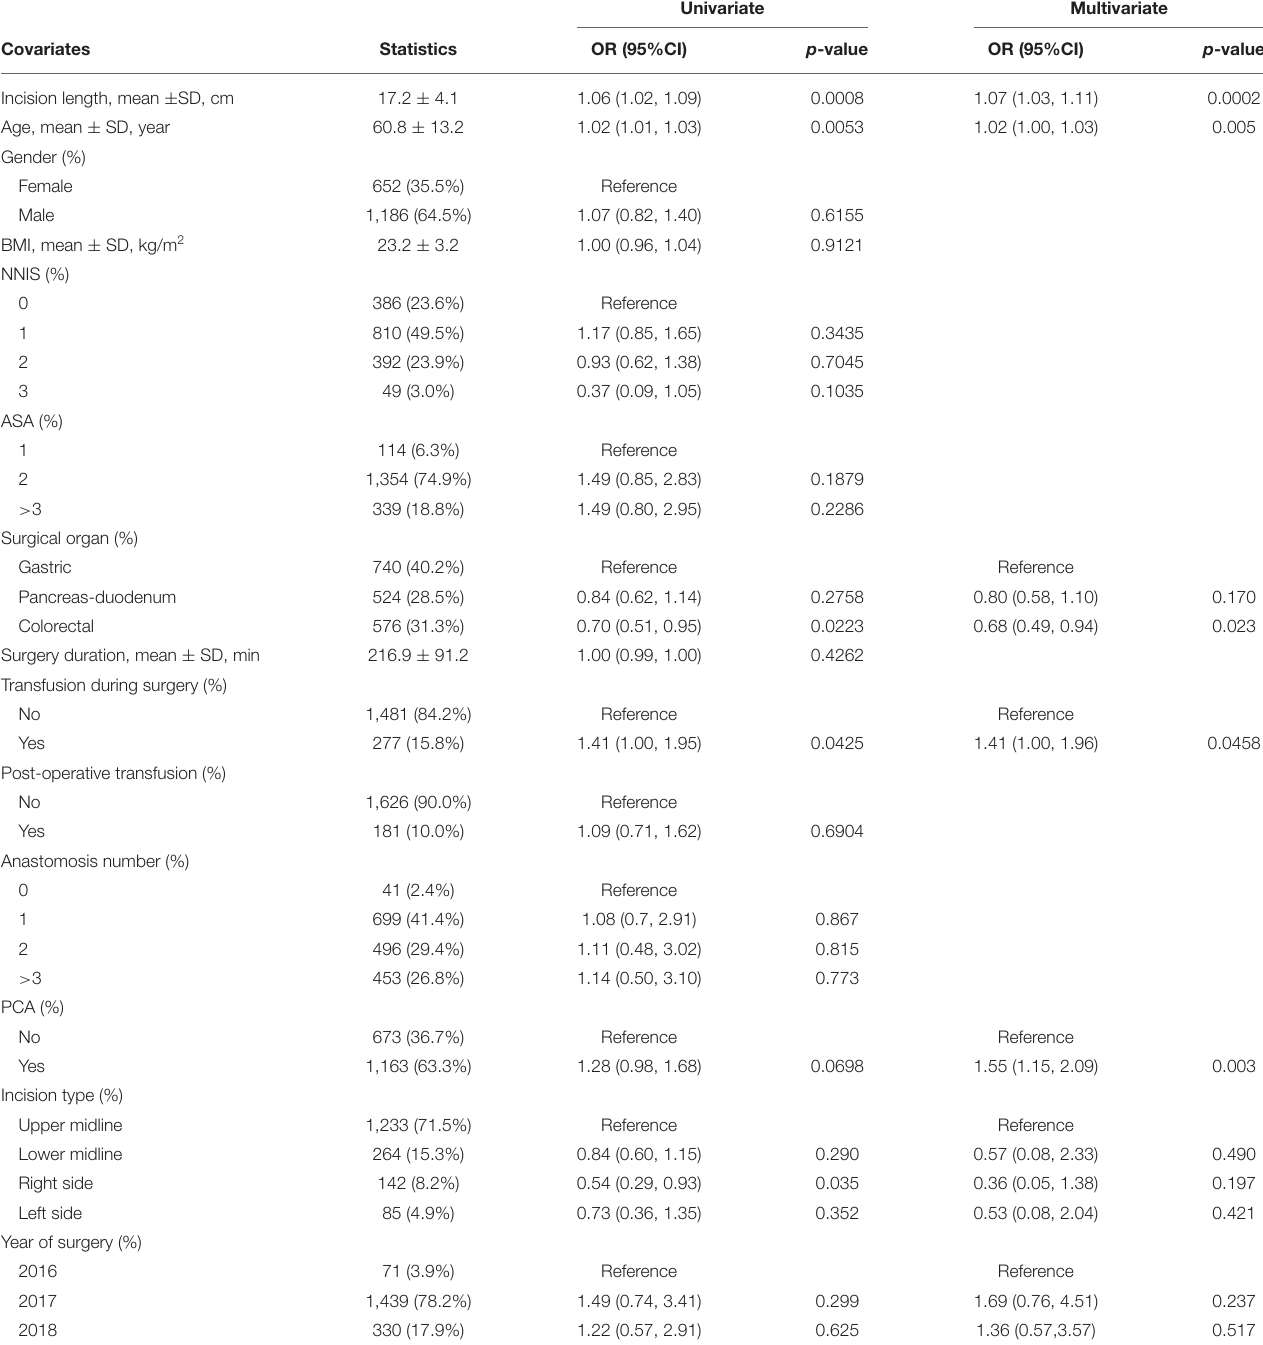
Univariate Multivariate